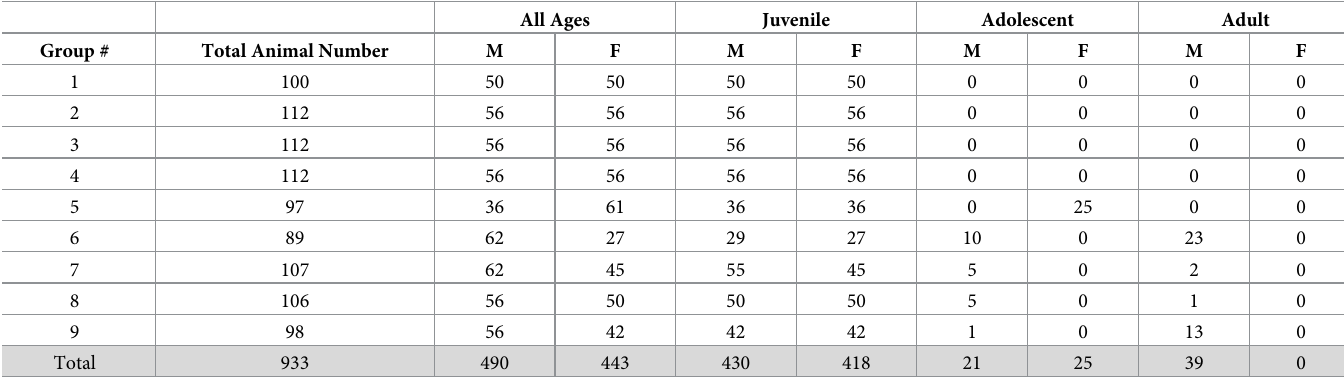
Table 1. Total animal population by group, age and